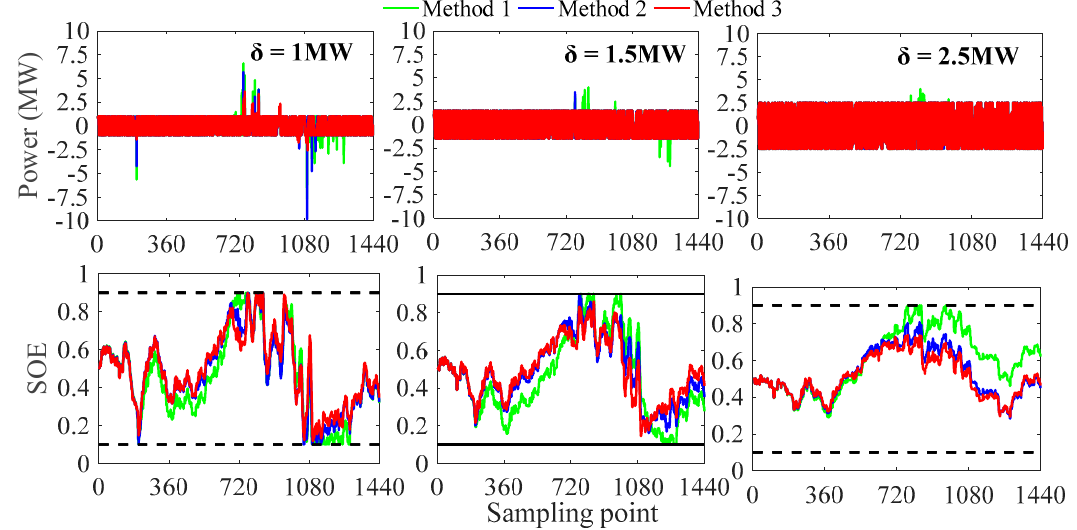
Figure 15. Comparison curve of Δ P G and SOE with three methods under different δ .